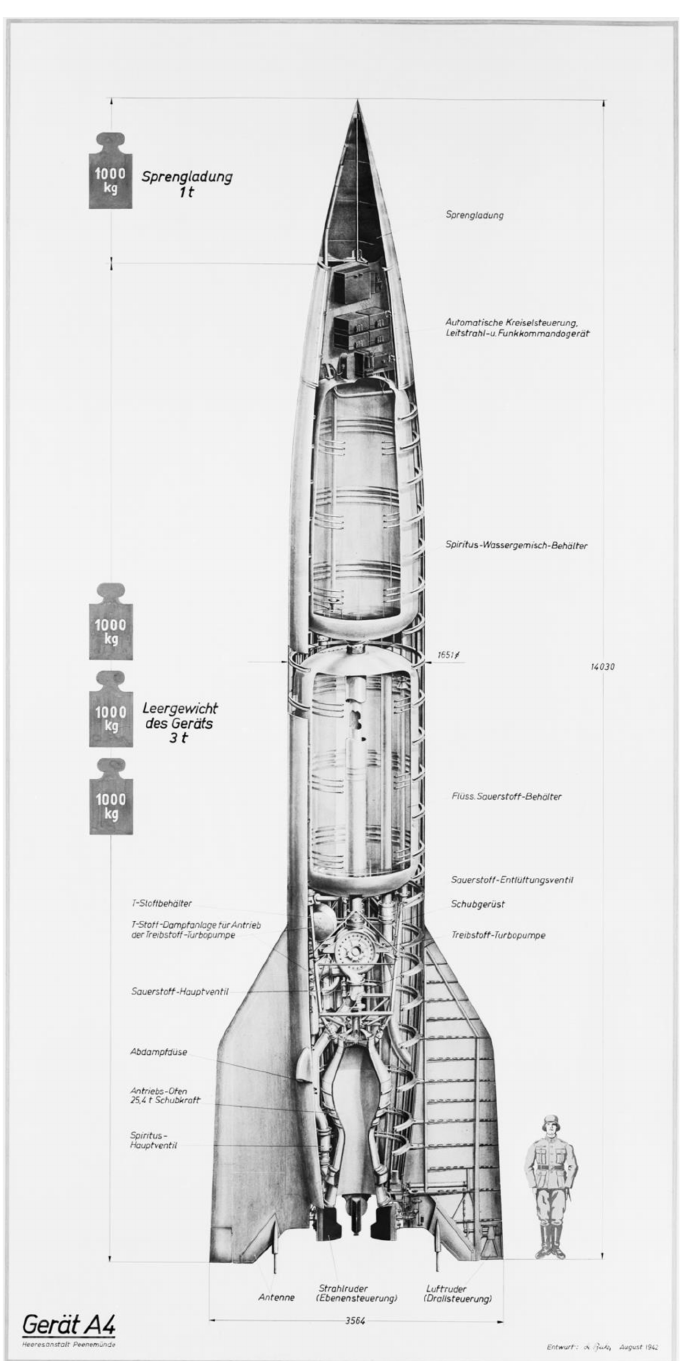
Figure 3: Cross-section of A-4 (V-2). Archive Deutsches Museum Munich, BN09206 Peenemünde ‘A4 Schnittbild’. Reproduced with permission of the